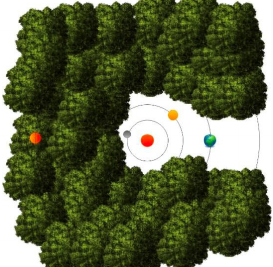
Figure 6. Game arena in the city